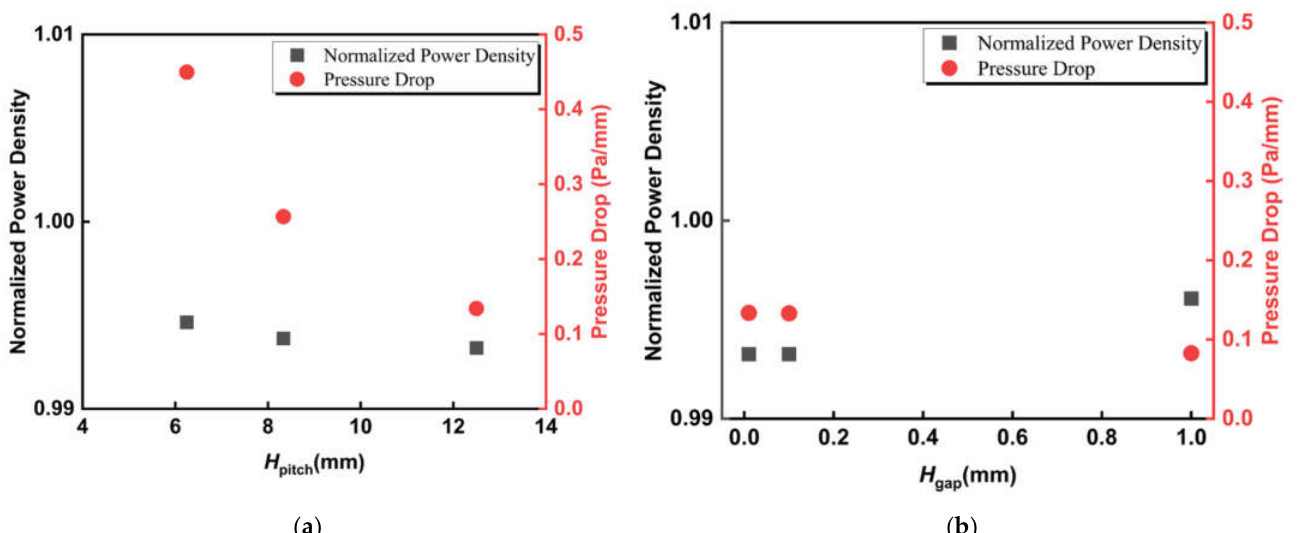
Figure 15. The influence of helical screw insert of different ( a ) pitches and ( b ) gaps on normalized power density and pressure drop of micro-tubular SOFC.